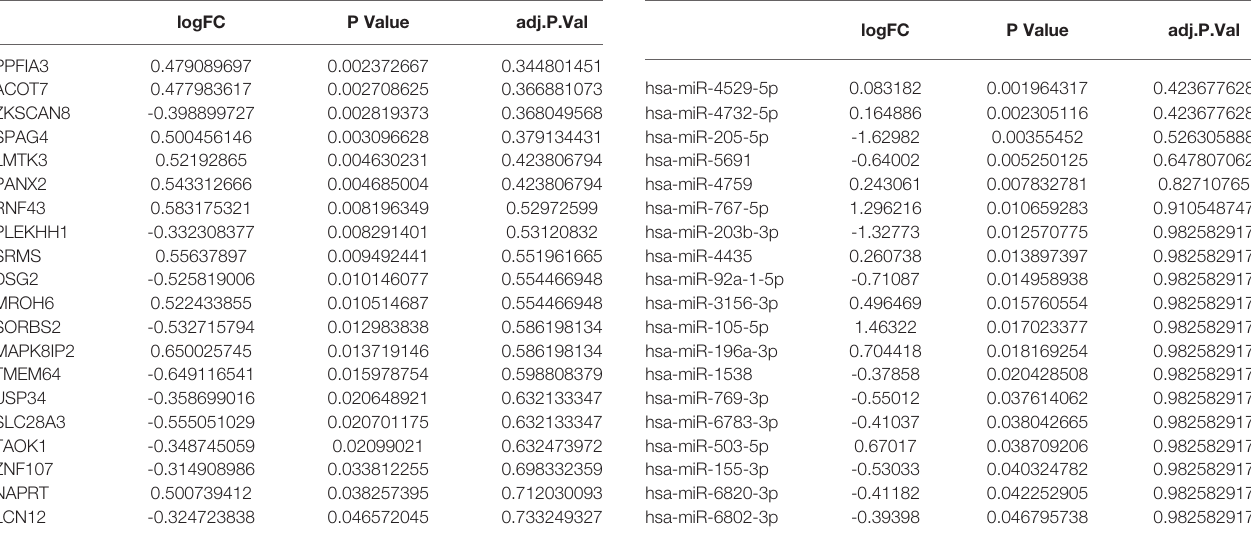
FIGURE 2 | The biological function of (KEGG pathways (P < 0.05) of DEMAmRNAs (A) and DEMAmiRNAs (D) . GO terms (P < 0.05) of DEMAmRNAs (B) and DEMAmiRNAs (C) , KEGG, Kyoto Encyclopedia of Genes and Genomes; GO, Gene Ontology; DEMARs, differentially expressed and metastasis associated RNAs; DEMAmRNAs, differentially expressed and metastasis associated mRNA; DEMAmiRNAs, differentially expressed and metastasis associated miRNAs. TABLE 1 | Differentially expressed and metastasis associated mRNAs in TABLE 2 | Differentially expressed and metastasis associated miRNAs in ceRNA network. ceRNA